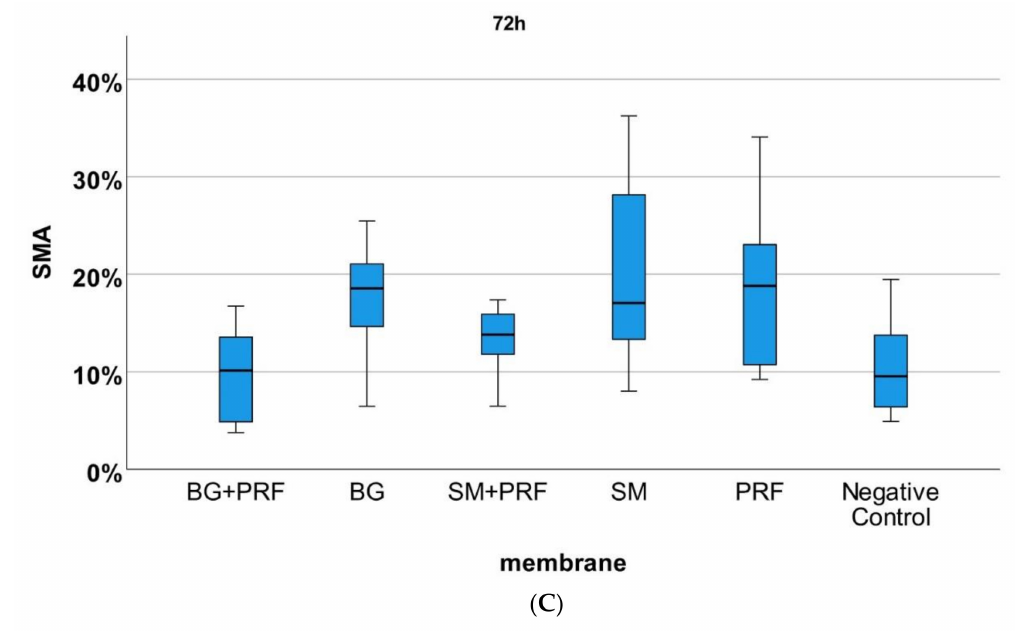
Figure 7. Analysis of aSMA immunohistochemical staining for the respective matrix (BG + PRF: Bio-Gide ® with PRF, BG: native Bio-Gide ® , SM + PRF: Symbios ® with PRF, SM: native Symbios ® , PRF, negative control). ( A ) 24 h, ( B ) 48 h, ( C ) 72 h of incubation. * marks statistically significant differences ( p < 0.05; for details, please see the responding paragraph).